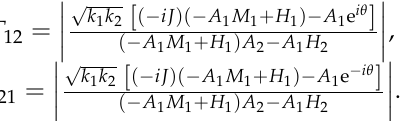
, ( c ) (cid:2016) (cid:3404) (cid:3095) , ( d ) (cid:2016) (cid:3404) , ( c ) θ = π , ( d ) (cid:2872) (cid:2870) 2 4